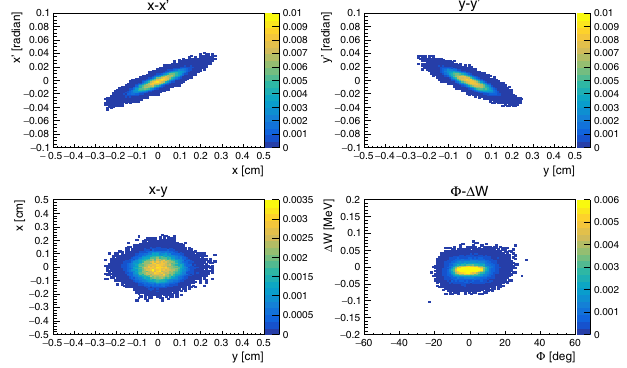
FIG. 10. Beam emittance, beam spread, phase spread, and energy spread for 2.5-MeV simulation. The top-left and top-right correspond to x-x ’ and y-y ’ (cm-mrad), respectively. The bottom- left denotes the beam spread (cm). The bottom – right denotes energy spread-phase spread. Theses scatter plots are created by the number of MC events of beam simulation conducted with RFQGen software and the integrated numbers of them are normalized to be 1. These histograms are divided with 100 × 100